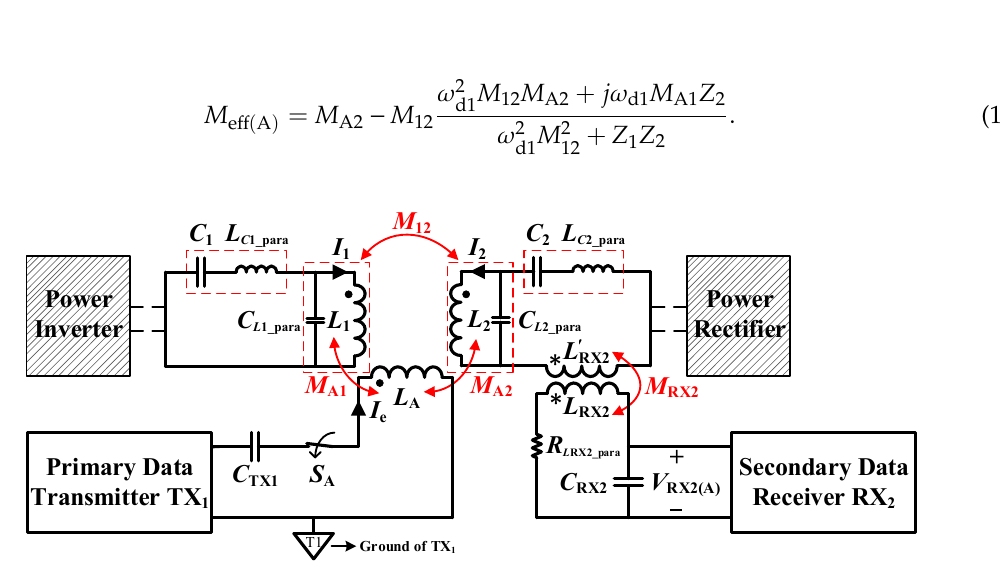
Figure 3. Positioning circuit model when L A is energized.